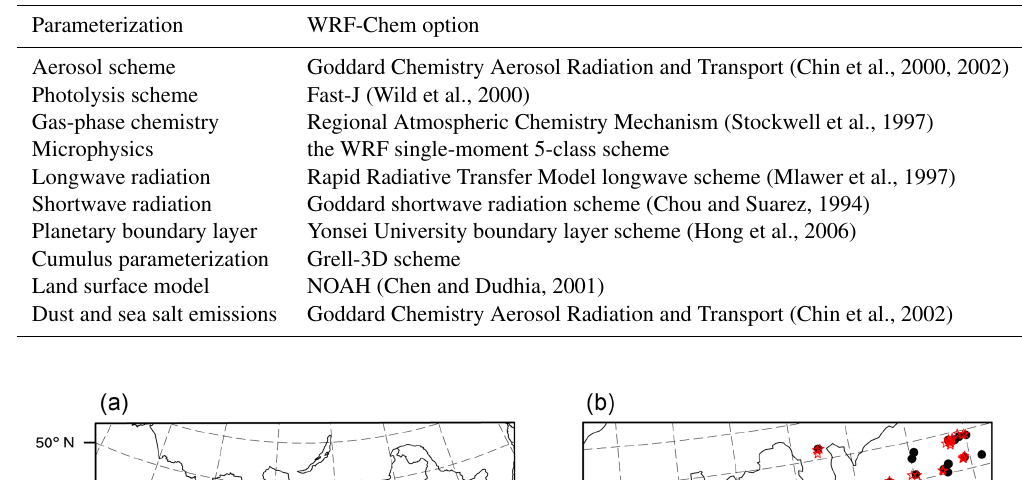
Table 1. WRF-Chem model configurations in this study.